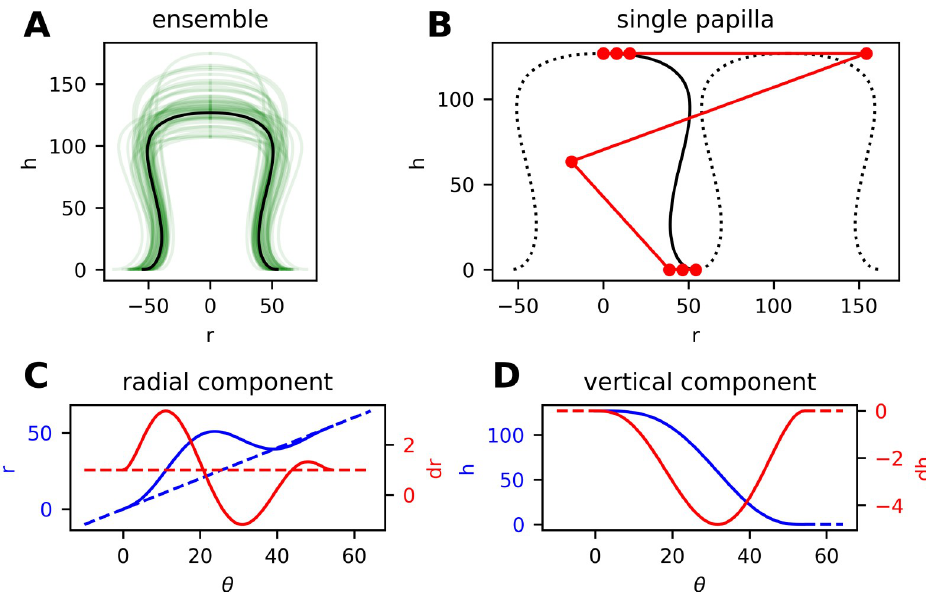
Fig 7. B-spline model for the shape of dermal papillae. (A) Lateral section of an ensemble of randomly generated papillae (green lines). (B) Positioning of control vertices (red markers connected by lines) for a particular shape curve (black). The positions of the fourth and fifth vertex along the r -axis can be altered with the shape parameter p . (C, D) Radial and vertical component of the shape curve (blue) with corresponding derivatives (red) and auxiliary lines. Compare the differentiability requirements in Eq